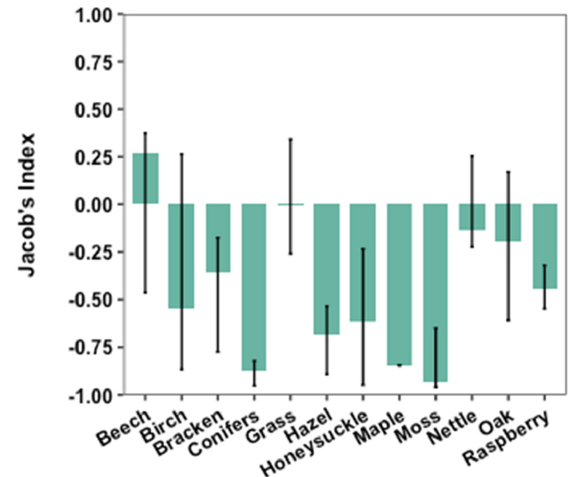
Figure 4. Selectivity indices (Jacob’s index of selection) for 12 nest materials occurring in both hazel dormouse nests and the surrounding vegetation. Materials with an index between 0 and 1 are selected for, while materials with an index between 0 and − 1 are avoided. Materials close to 0 are considered neutral, meaning that they are neither selected nor avoided. The lines through the bars show the interquartile range (25–75%).